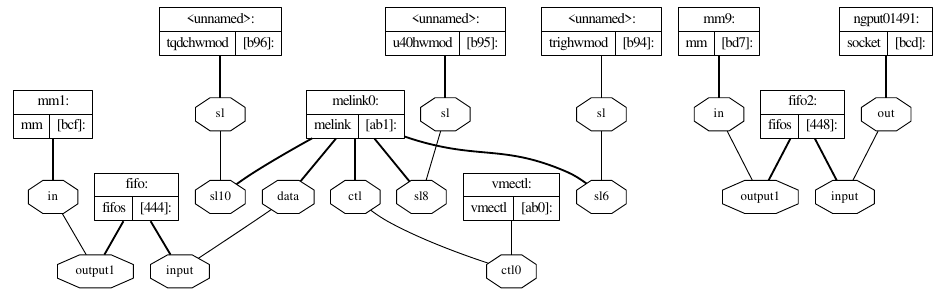
Figure 1. The simplified netgraph graph used by DSS DAQ system to deal with VME hardware and manage the produced data streams. Rectangles are nodes with: name (up), type (left), ID (right); octagons represent hooks with their names